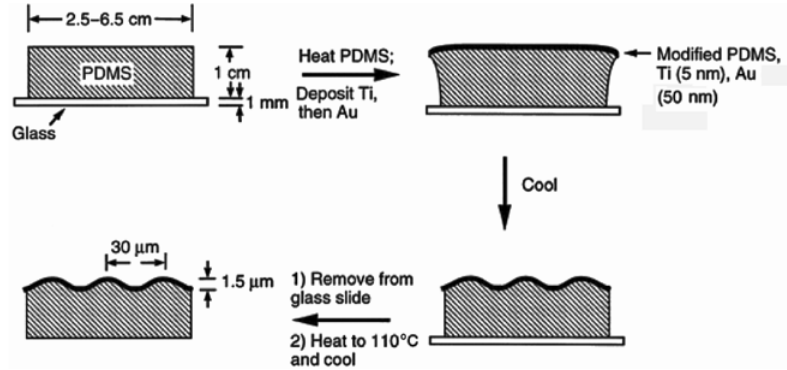
Figure 5: Schematic illustration of the fabrication of self-assembled nanostructures (reprint with permission Ref. [68]; Copyright 1998, Rights Managed by the Nature Publishing